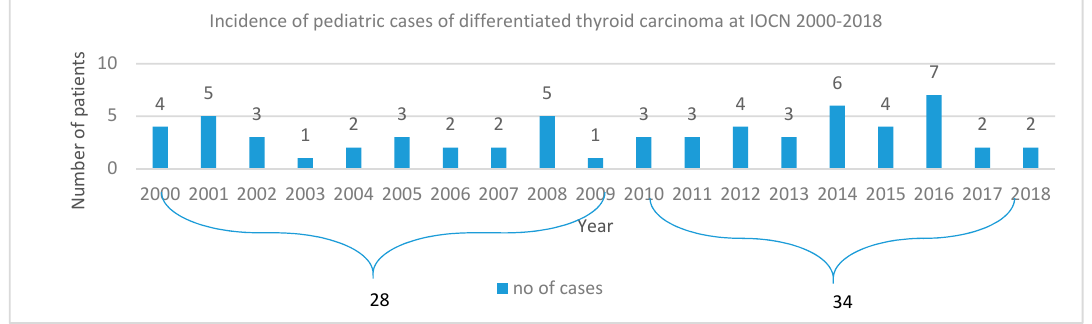
Figure 5. Incidence of pediatric differentiated thyroid carcinoma at “Prof. Dr. Ion Chiricu ţă ” Institute of Oncology (IOCN) in 2000–2018.